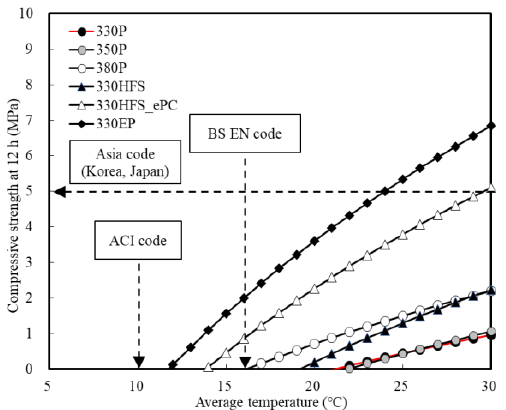
Figure 12. Variation in the concrete the strength according to the average temperature after 12 h.